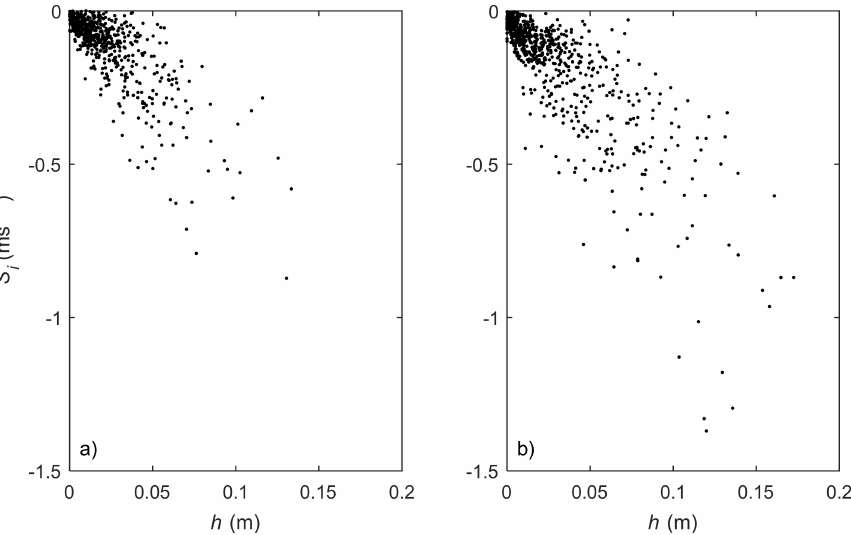
Figure 12. Overtopping volume infiltration rate as a function of the mean depth of the overtopped flow volume: ( a ) 1DR and ( b )